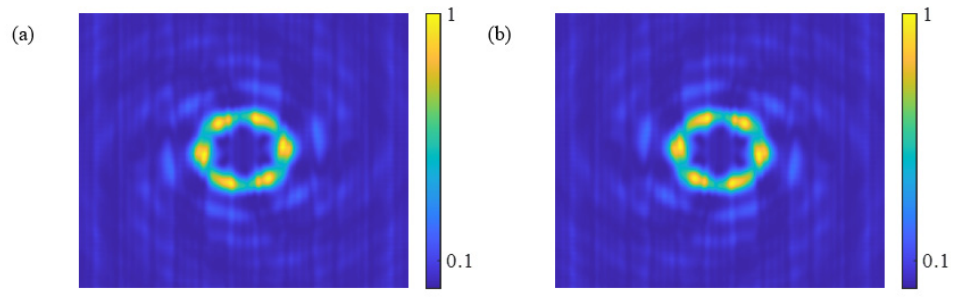
Figure 5. Simulated normalized diffraction patterns for the CSZPG with ( a ) l = 6 and ( b ) l = − 6, re- spectively.